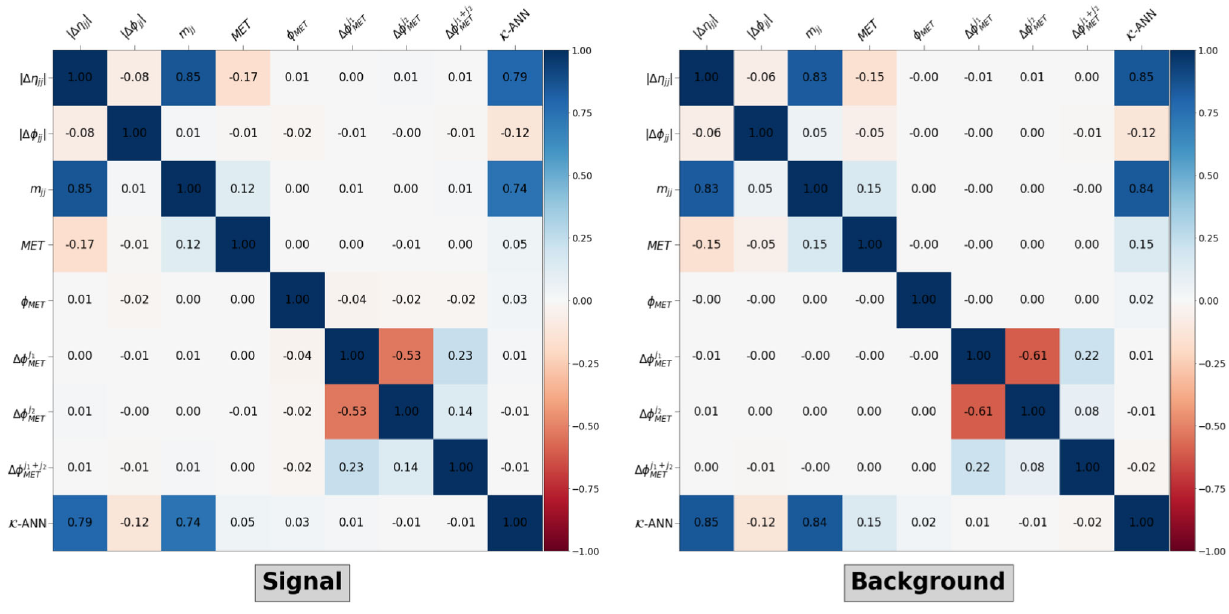
Fig. 20 Correlation between the high-level kinematic variables K and the network-output of K -ANN for (left) signal and (right) background